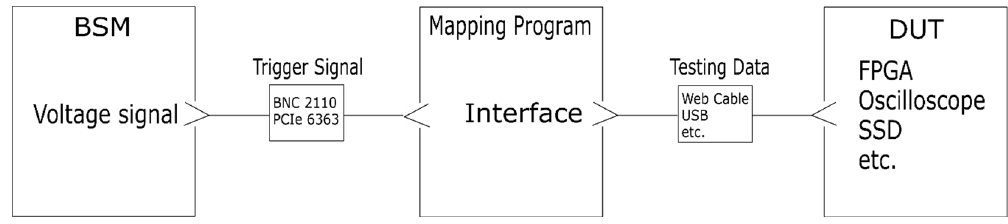
Figure 10. Structure of SEE mapping system.